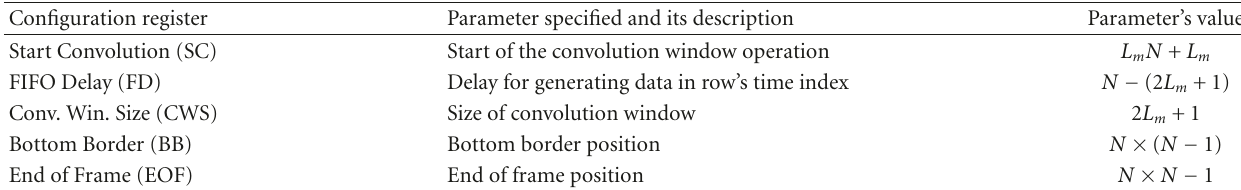
Table 5: Parameters from configuration registers, expressed by the number of needed STFT Load cycles.